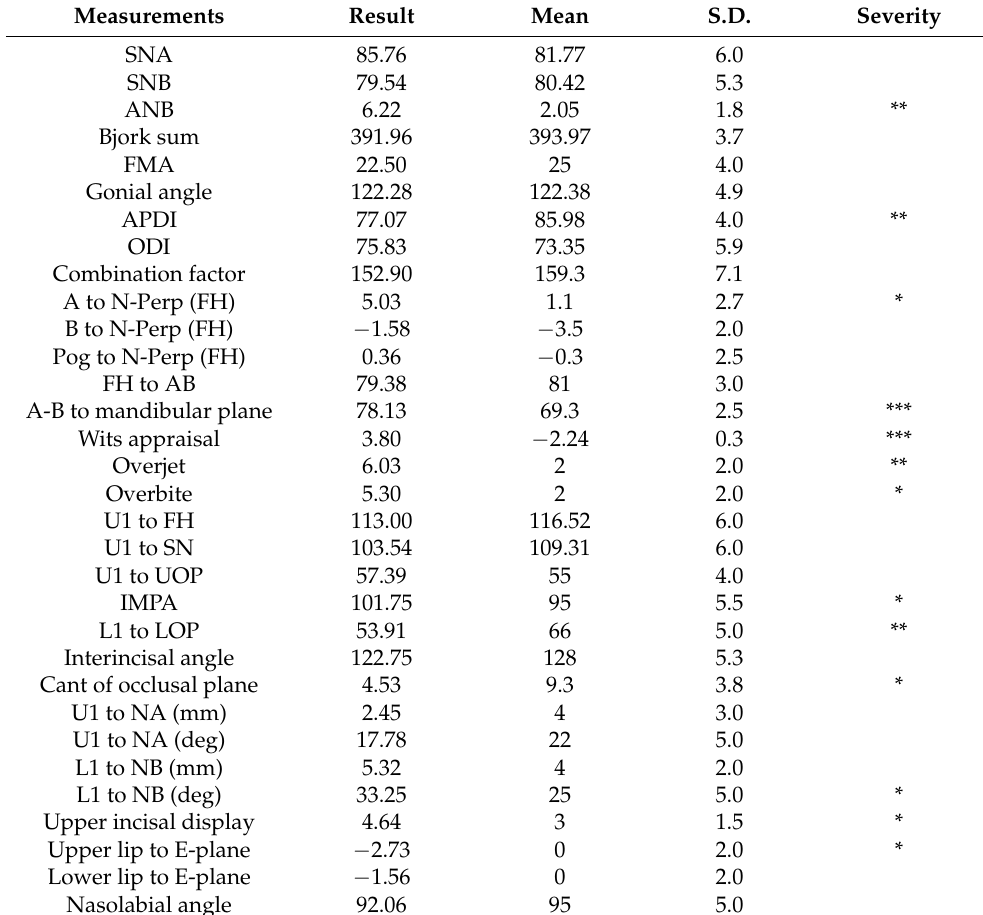
Table 3. Pre-treatment cephalometric values of case number 2.